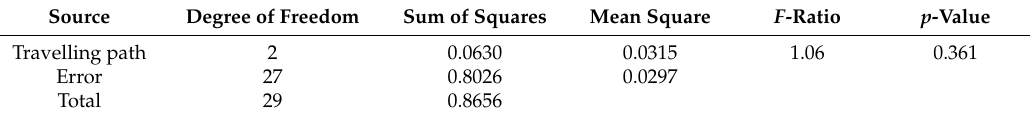
Table 12. ANOVA table of the s-value for experiment #2-1 (2-kW fiber laser welding system). Source Degree of Freedom Sum of Squares Mean Square F -Ratio p -Value Travelling path